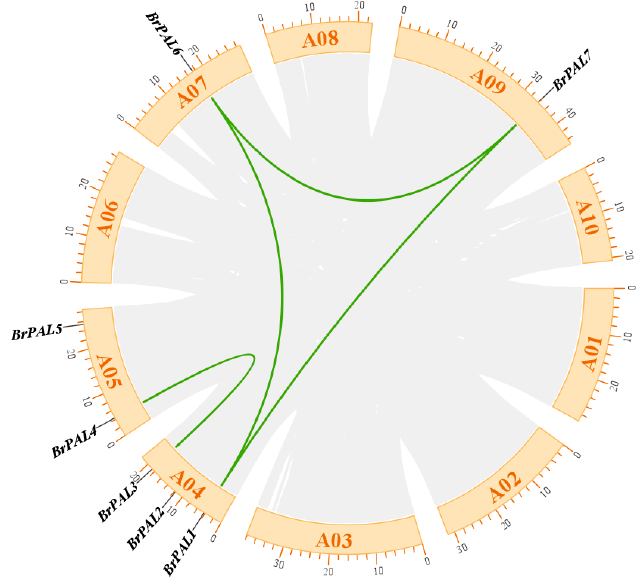
Figure 3. The distribution and segmental duplication of PAL genes in Brassica rapa , the yellow panel uses circles to show ten chromosomes A01 ‐ 10 are Brassica rapa chromosome numbers, the green lines represent collinear gene pairs, and the gray areas are collinear regions.